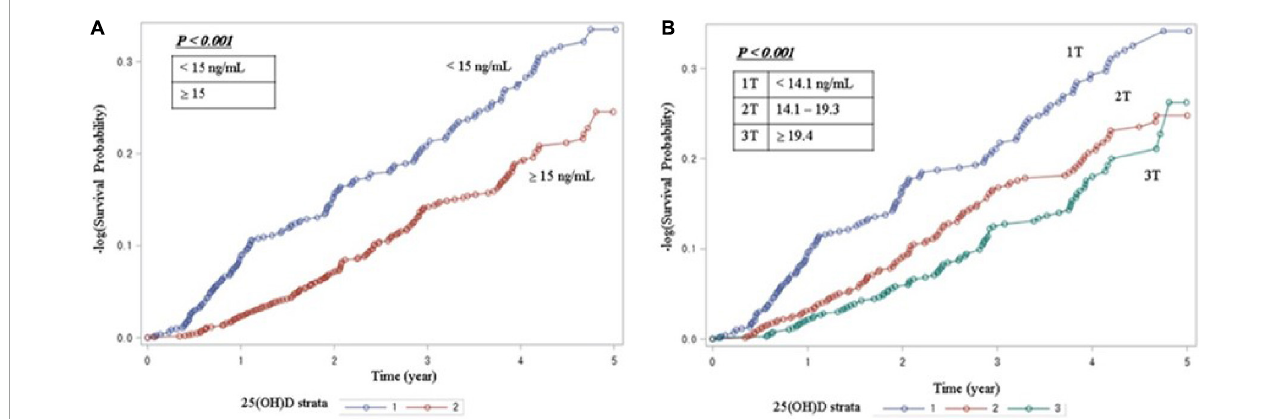
FIGURE2 Kaplan-Meier survival analysis for serum vitamin D levels (A) Survival curve for renal event by binary of 25(OH)D. (B) Survival curve for renal event by tertiles of 25(OH)D. The Kaplan-Meier curves show that the patient with vitamin D deficiency group had a significantly higher cumulative incidence of renal events ( P < 0.001). 25(OH)D, 25-hydroxyvitamin D.